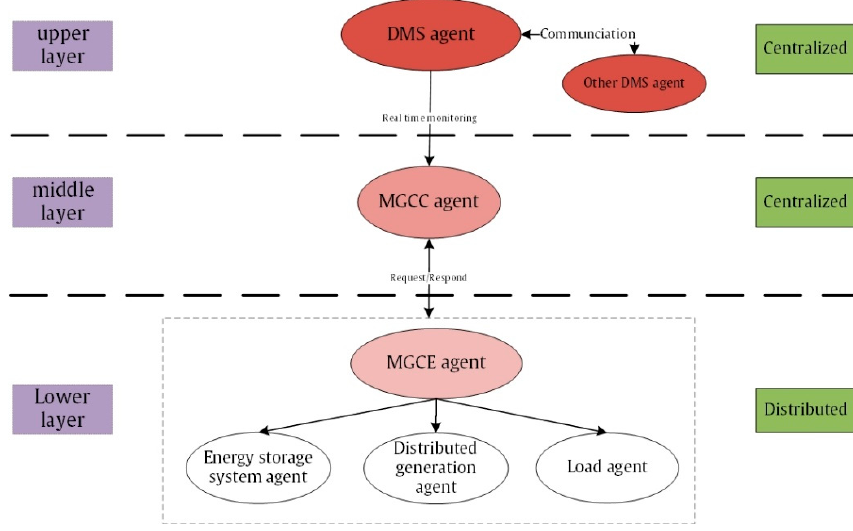
Figure 1. The structure of three-layer MAS of MG.